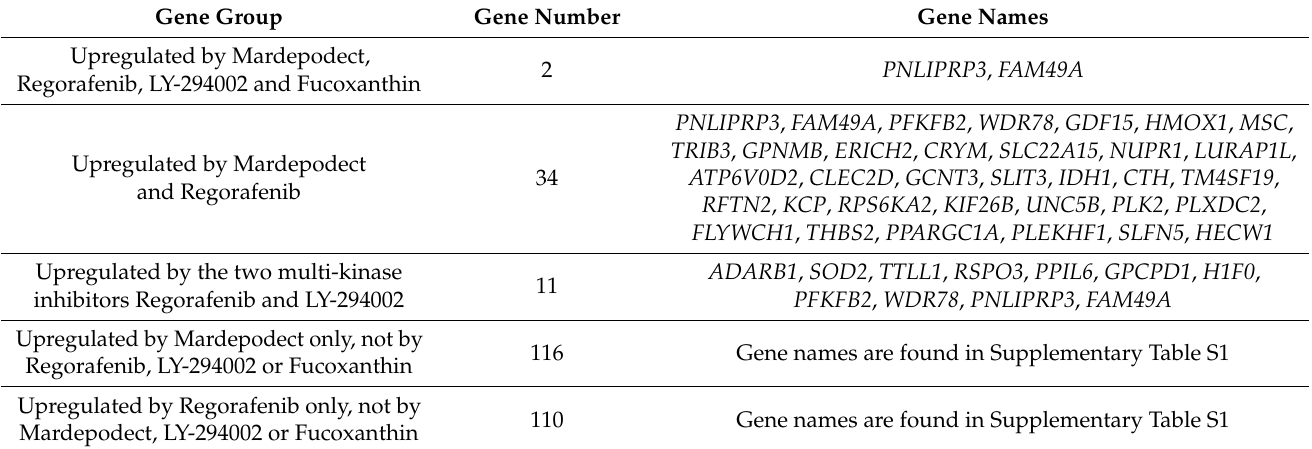
Figure 2. Four-way Venn diagram showing an analysis of the 200 genes with most elevated expression levels in U87MG cells treated with Mardepodect (MAR), Regorafenib (REG), LY-294002 (LY), and Fucoxanthin (FX). Table 1. Genes, partitioned between the drug treatments, based on sets of 200 genes with most elevated expression levels in U87MG cells (shown in Figure